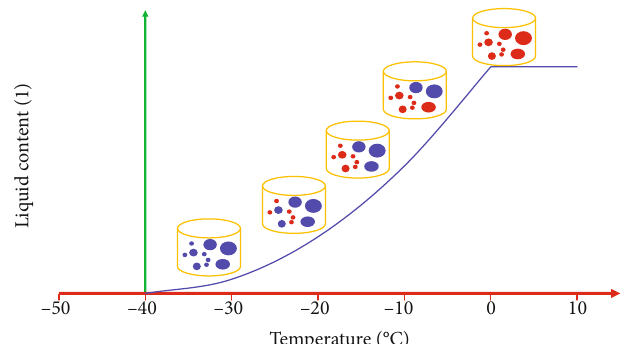
Figure 3: Melting point curve and phase transition behavior of water in porous materials (blue ball means solid; red ball means fl